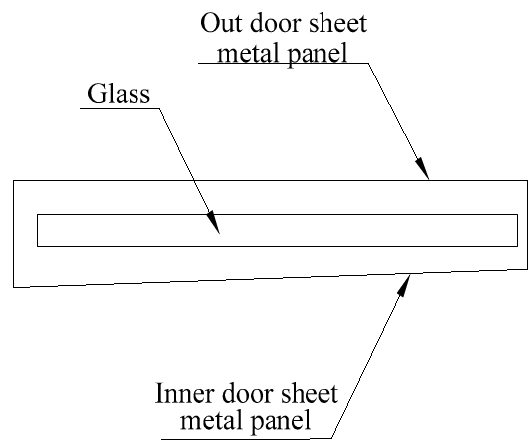
Figure 9. Simplified view of automobile window.